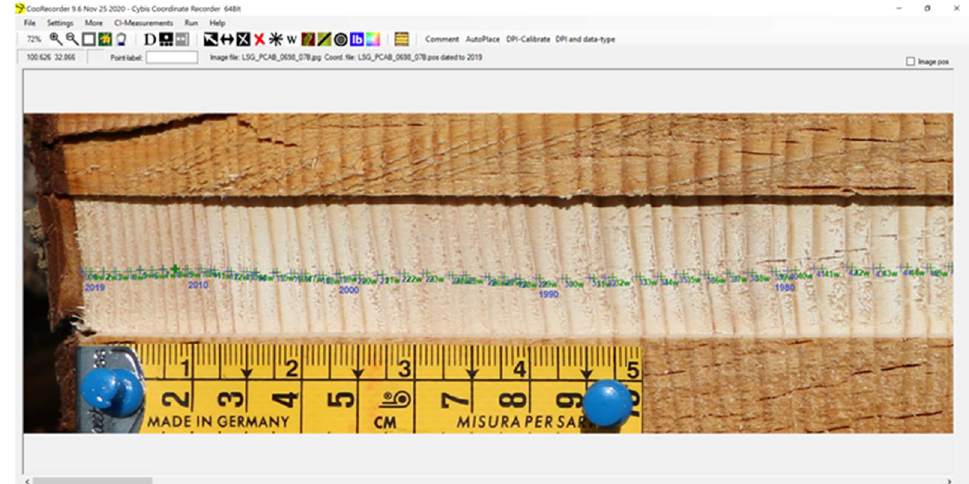
Figure 5. Tree-ring, earlywood, and latewood width measurements in CooRecorder on the image of a groove smoothed with a hand-held cordless trimmer.